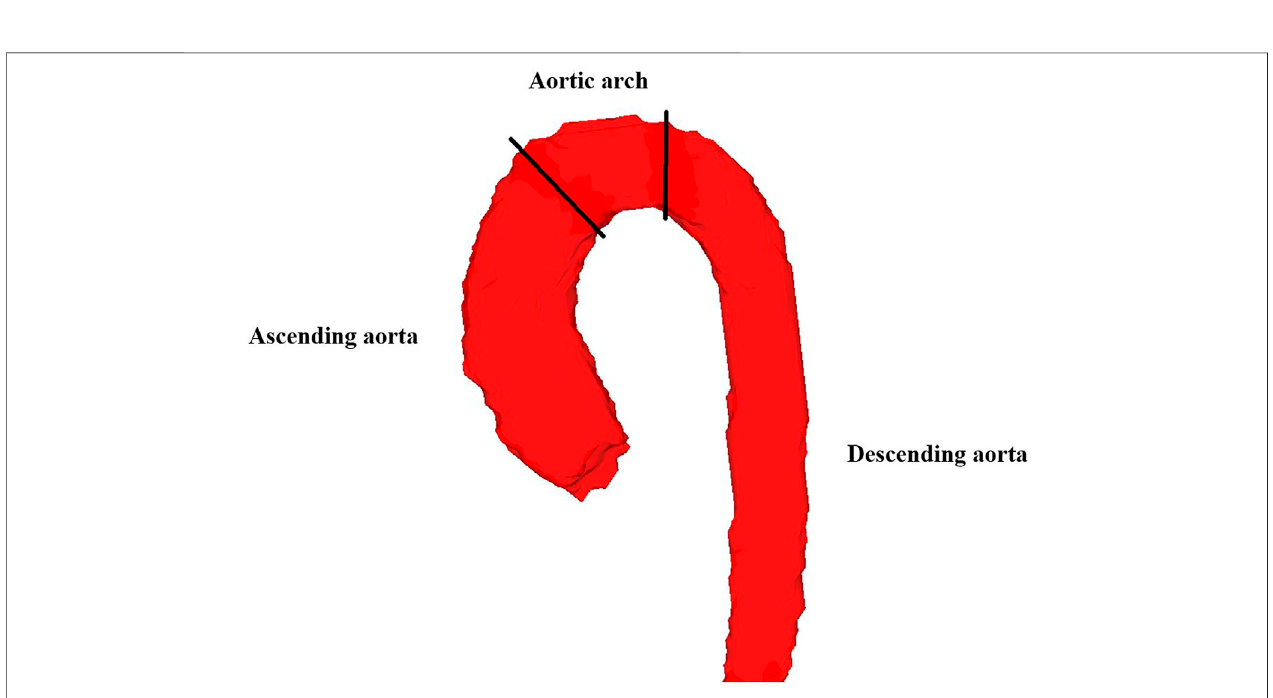
Frontiers in Physiology |